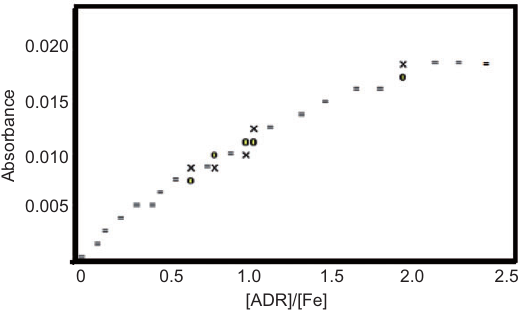
Figure 4 Computer fits of the plots of absorbance vs. [ADR]/[Fe] mole ratios at 25 ° C. ( × ) experimental point, (o) calculated point, ( = ) experimental and calculated points are the same within the resolu- tion of the plots.